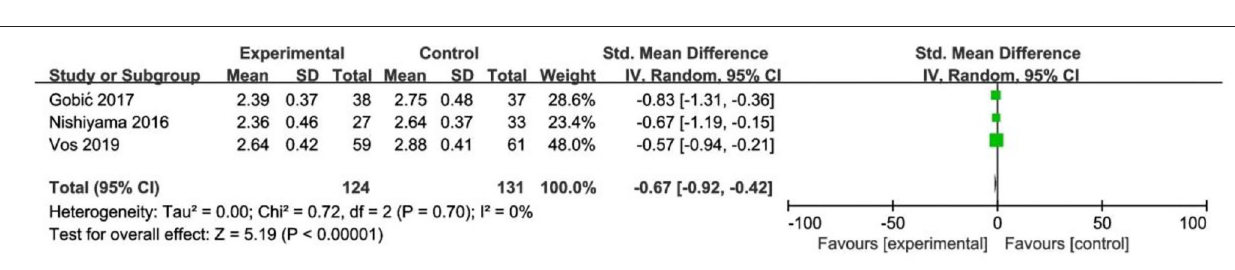
FIGURE 7 | Meta-analysis of the effects of DCB compared with control in LLL.